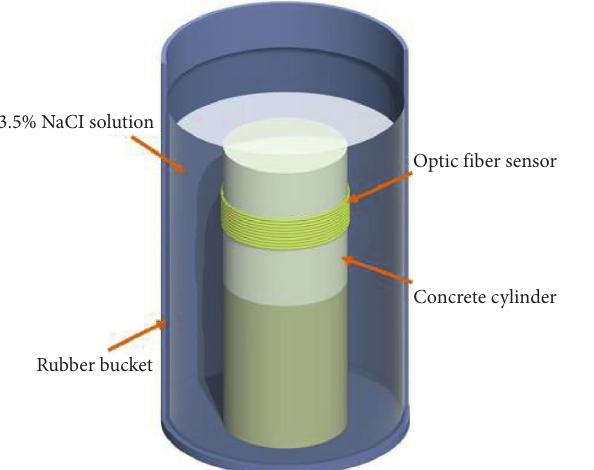
Figure 5: Schematic of the cylinder